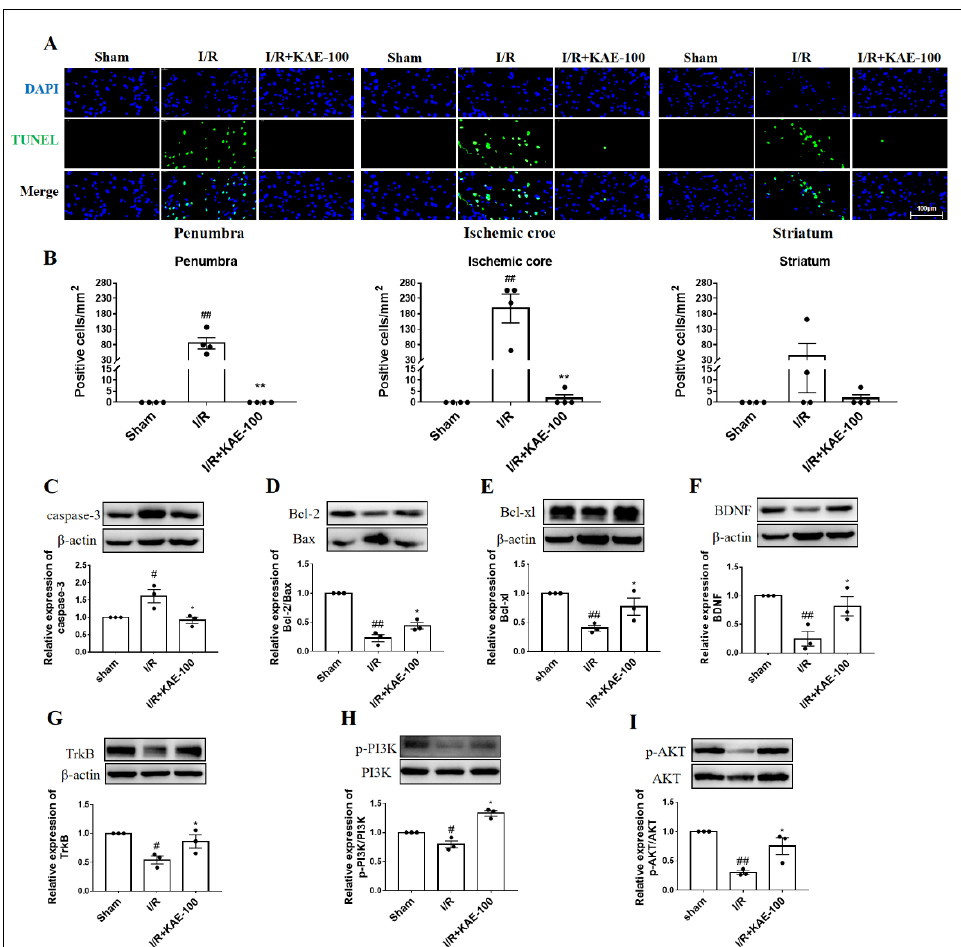
Figure 3. Effect of kaempferol on cell apoptosis of rats on day 3 after I/R. ( A ) Representative images of TUNEL staining (green) in penumbra. ( B ) Quantitative analysis of TUNEL-positive cells in penumbra, ischemic core and striatum ( n = 4). The nuclei were stained with DAPI (blue), 630 × magnification and scale bar = 100 µ m. The expression levels of ( C ) caspase-3, ( D ) Bcl-2/Bax, ( E ) Bcl-xl, ( F ) BDNF, ( G ) TrkB, ( H ) p-PI3K and ( I ) p-AKT were assessed by Western blot analysis. Values are expressed as mean ± SEM ( n = 3) # p < 0.05, ## p < 0.01 vs. Sham group; * p < 0.05, ** p < 0.01 vs. I/R group. KAE: kaempferol.